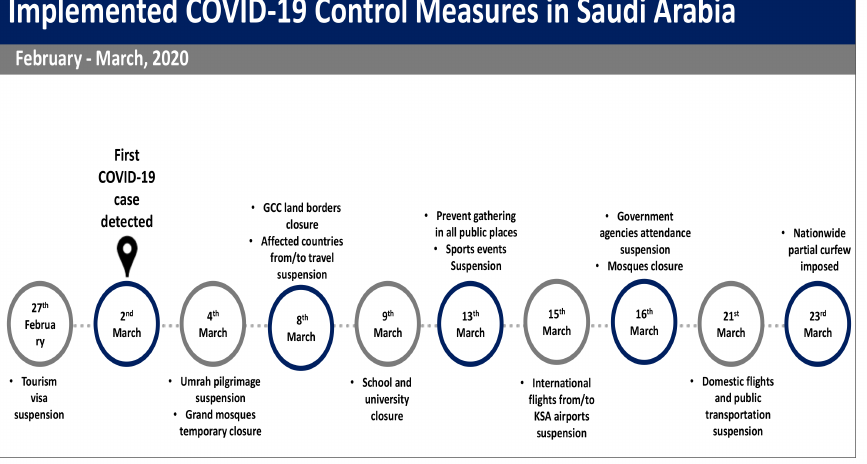
Figure 1. Timeline of Saudi Arabia response to compact COVID-19 spread in the first 4